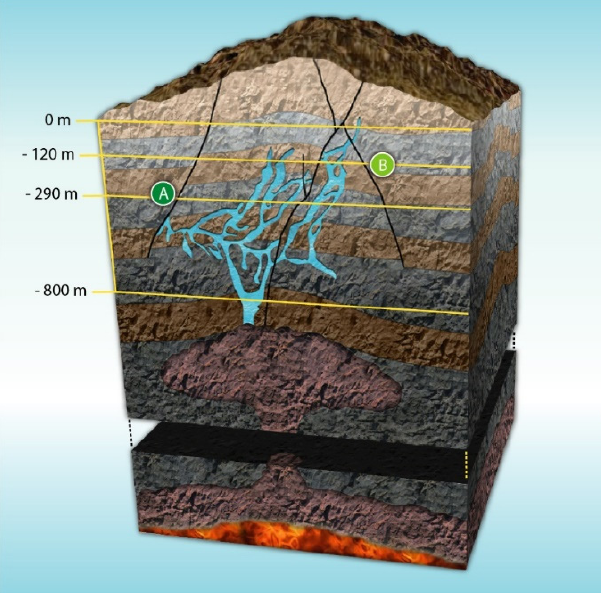
Figure 2. Cross-section of Naica’s complex. ( A ) Crystal Cave and ( B ) Swords Cave. Adapted and